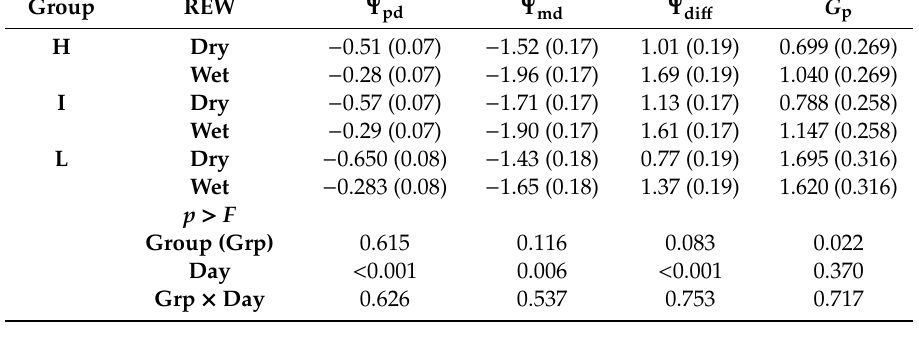
Table 2. Tree leaf water potential ( Ψ ) and whole-plant hydraulic conductance ( G p ), measured under wet (REW > 0.30) and dry (REW < 0.20) soil conditions. Leaf water potential was measured at predawn ( Ψ pd ) and at midday ( Ψ md ) ( Ψ di ff = Ψ pd − Ψ md ). Data are lsmeans (SE) for clones within Group with